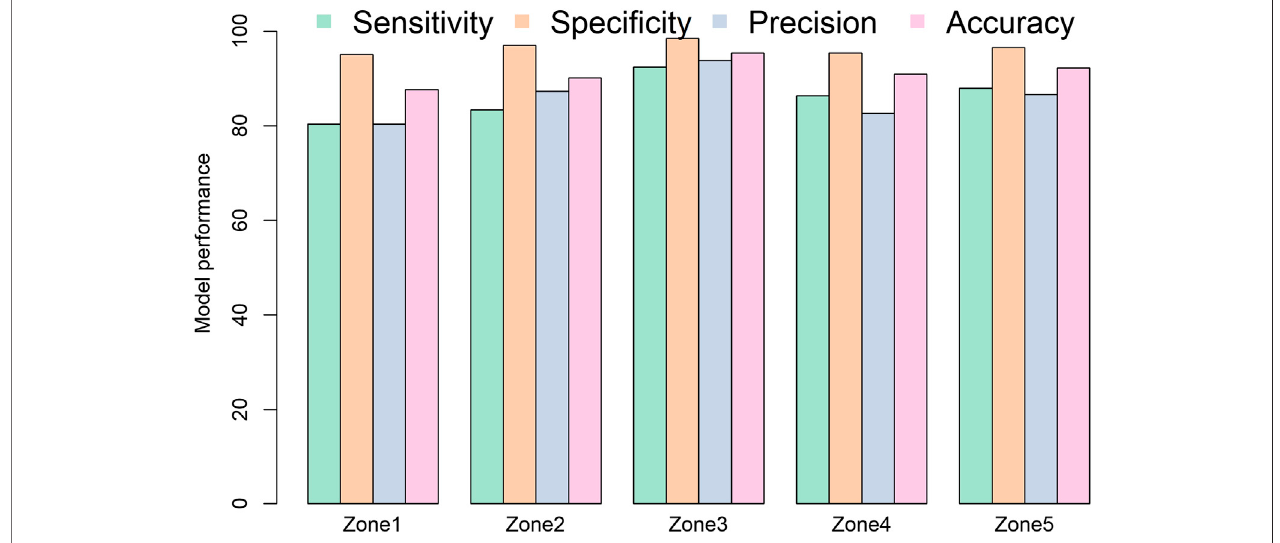
FIGURE 5 | Zonal CNN model-performance confusion matrix using a time-domain – stacked encoding approach.